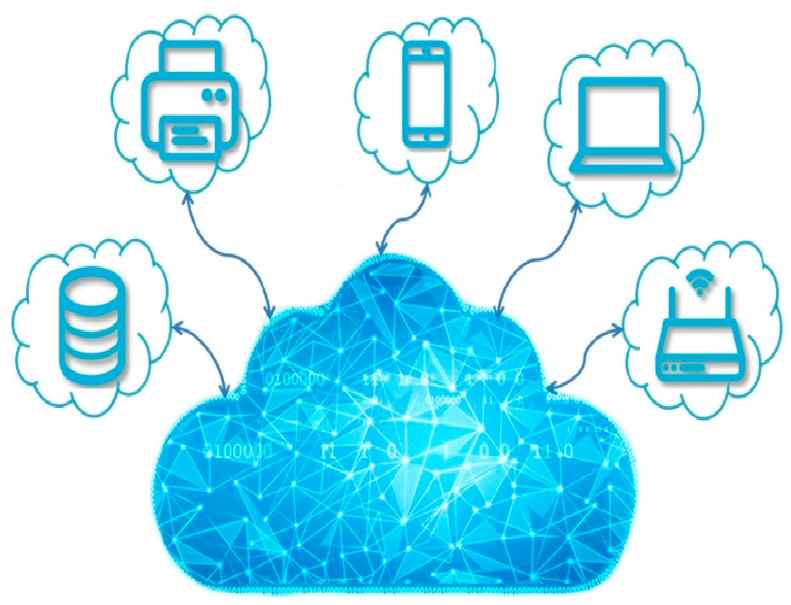
Figure 5. Cloud Computing.